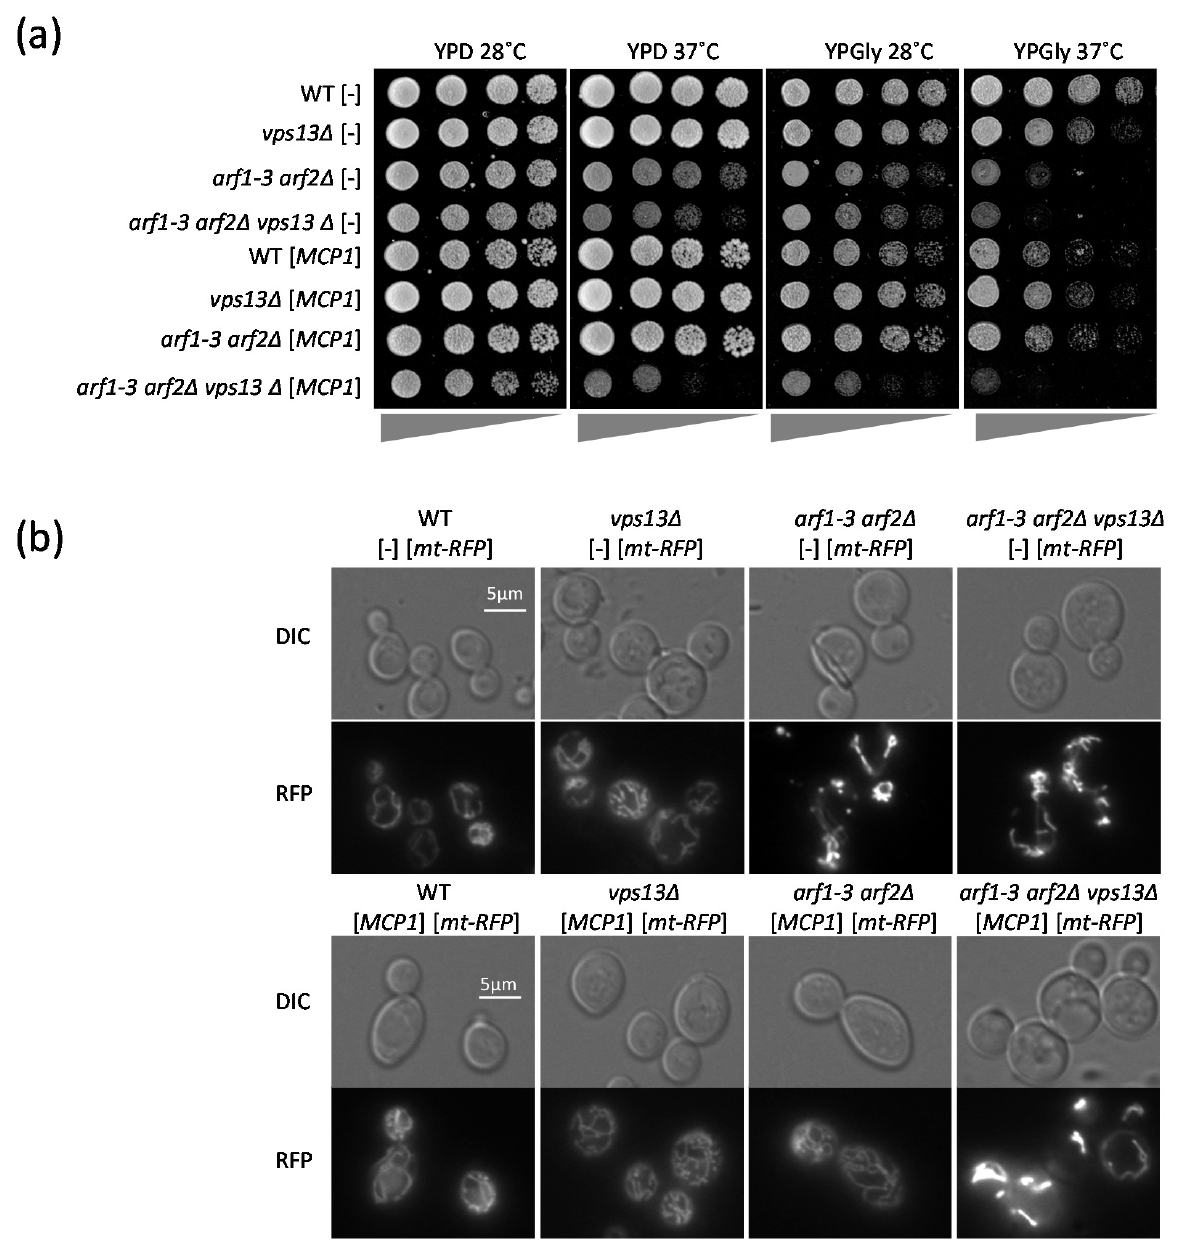
Figure 2. Vps13 and Arf1 influence mitochondria independently. ( a ) The arf1-3 arf2 ∆ vps13 ∆ strain shows a stronger growth defect in comparison to the vps13 ∆ or arf1-3 arf2 ∆ strains on media containing glycerol, a non-fermentable carbon source, and Vps13 is necessary for suppression of the growth defect of the arf1-3 arf2 ∆ strain by overexpression of the MCP1 gene. The growth analysis of WT and the vps13 ∆ , arf1-3 arf2 ∆ , and arf1-3 arf2 ∆ vps13 ∆ strains, transformed with empty plasmid or carrying the MCP1 gene, on YPD or YPGly media was carried out. Overnight liquid cultures of the indicated strains were diluted to the same density, serially diluted (4 × ), and spotted on glucose (YPD) or glycerol (YPGly) containing media. Plates were incubated at 28 ◦ C or 37 ◦ C for 2–5 days. ( b ) The Mcp1-dependent suppression of the mitochondrial morphology defect of the arf1-3 arf2 ∆ strain requires the presence of Vps13. The morphology of mitochondria was determined by fluorescence microscopy in WT and the vps13 ∆ , arf1-3 arf2 ∆ , and arf1-3 arf2 ∆ vps13 ∆ strains carrying plasmids encoding a red fluorescence protein targeted to the mitochondria ( mt-RFP ), a plasmid encoding Mcp1 ( MCP1 ) or empty plasmid (-). Cells were also visualized by DIC microscopy.